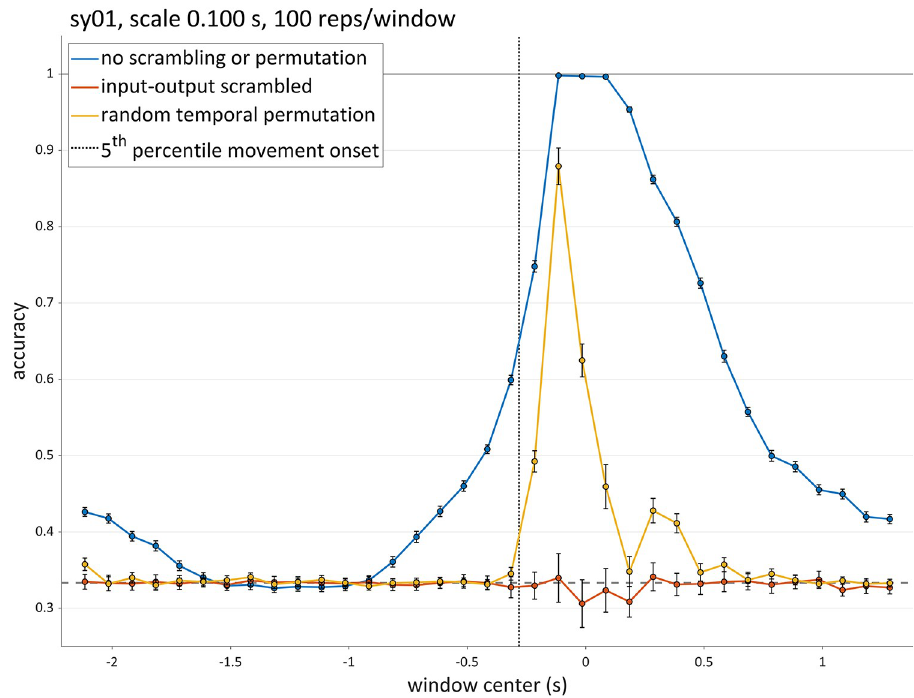
Fig 14. Accuracy confidence intervals for one speaker and scale (100 ms). Blue dots: analyses conducted on original data; orange dots: input-output mappings scrambled in training set; yellow dots: frames in each analysis window of training set randomly permuted. Error bars show 99% confidence intervals. Horizontal dashed line represents chance accuracy. Vertical dotted line shows the 5% percentile of movement initiation.